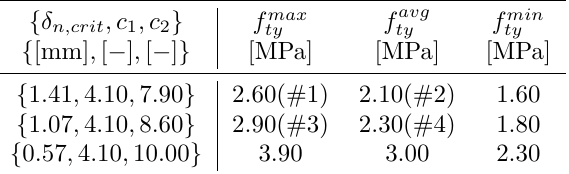
Table 3. Parameters of cohesive law estimated by trial-and-error approach to inverse analysis of max. load responses of CT specimens cut from arch crown.